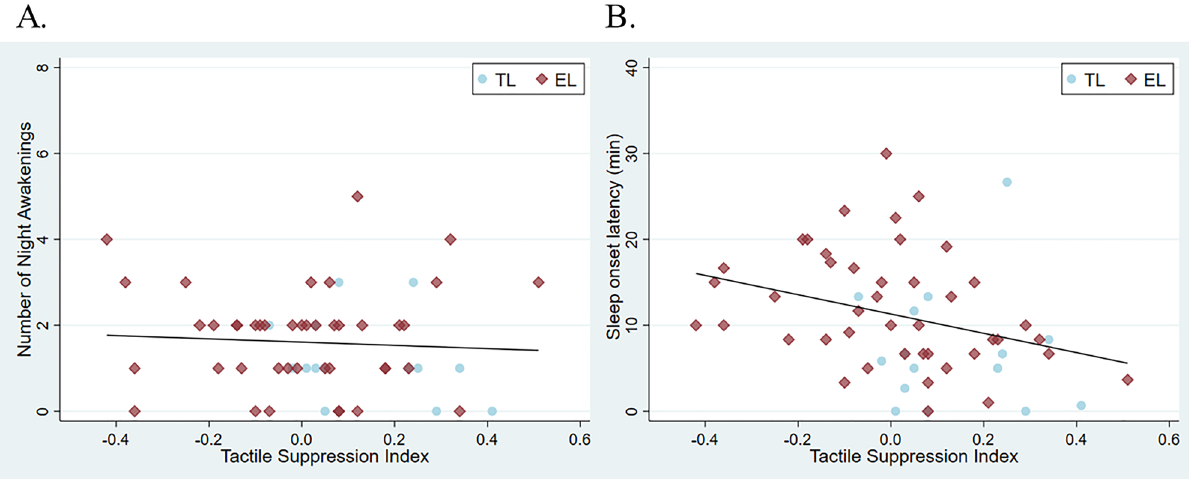
Figure 3. Associations with tactile suppression index (TSI) at the 10-month visit. Infants at typical likelihood for ASD (TL) are depicted in blue and infants at elevated likelihood for ASD (EL) are depicted in red. ( A ) The number of night awakenings is not significantly associated with TSI. ( B ) Sleep onset latency is significantly associated with